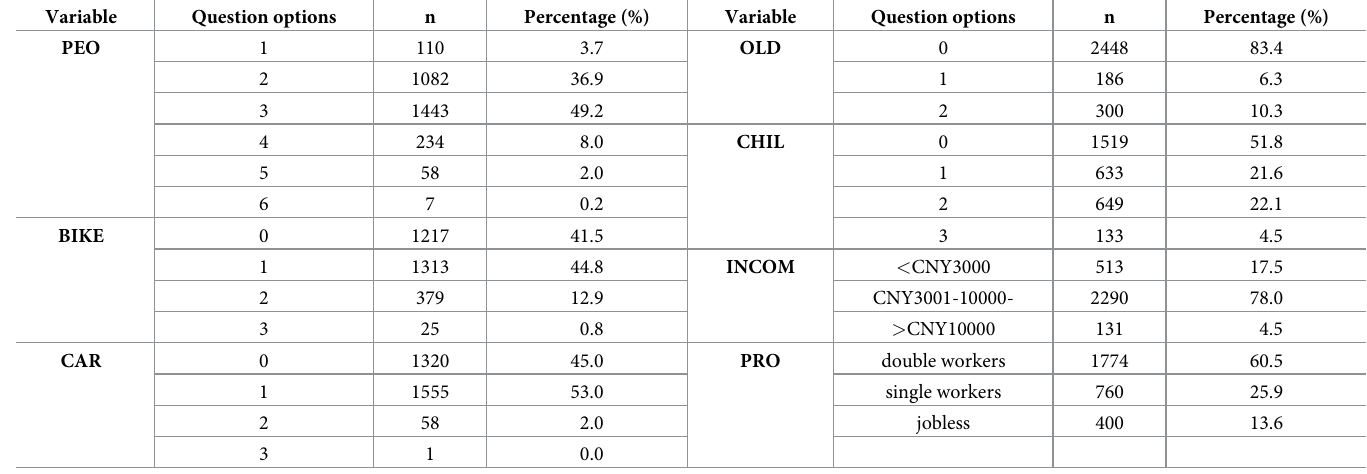
Table 1. Descriptive statistics for family socio-economic attributes (N =